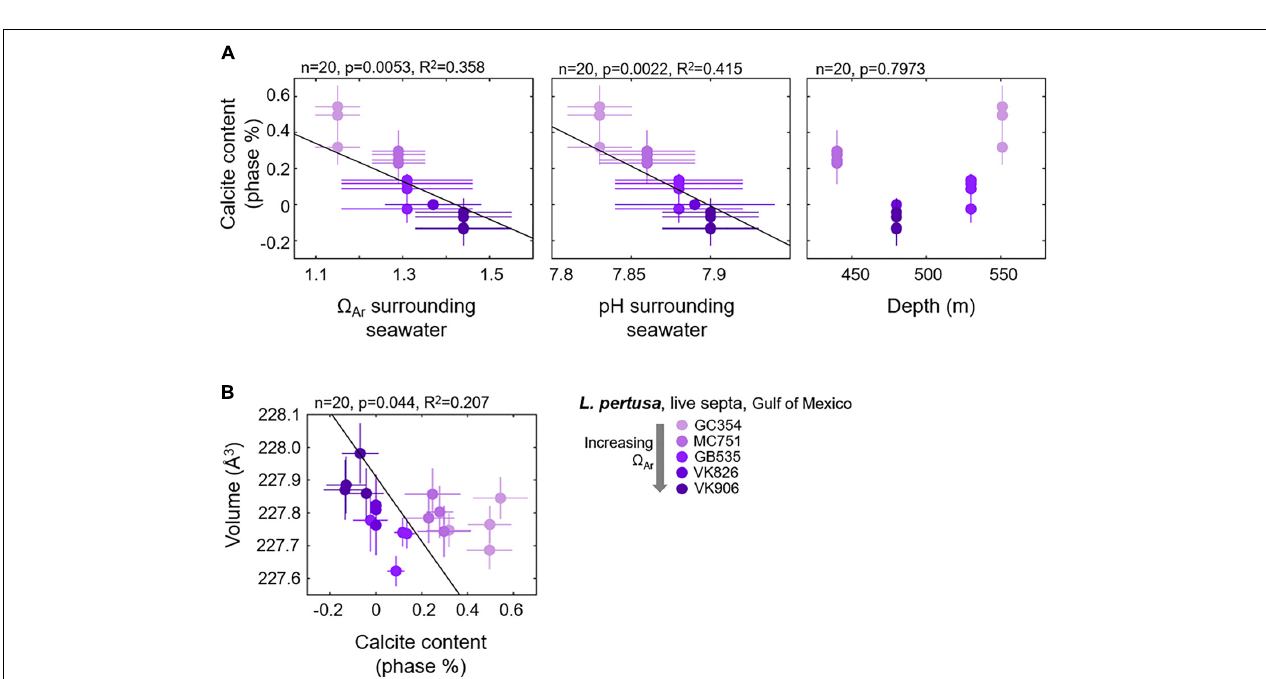
FIGURE 6 | Gulf of Mexico L. pertusa live septa (A) calcite contents as a function of surrounding seawater chemistry and depth, and (B) shifts in unit cell volume as a function of increasing calcite contents.